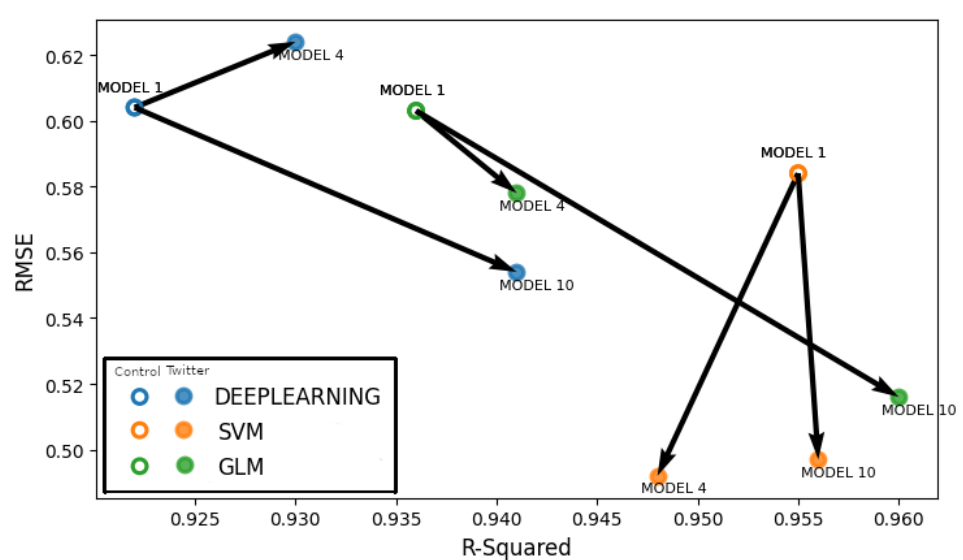
Figure 13. Performance comparison for Model 4 and Model 10 w.r.t. Model 1, which is the baseline control run, on the Test Dataset. The x-axis represents the correlation coefficient ( R 2 , R-Squared) and the y-axis represents the RMSE values. The arrows indicate performance improvements between the control run and the Twitter-based models. Each solid circle represents a Twitter-based model. Each hollow circle represents the control run